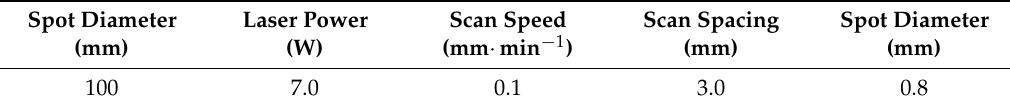
Table 1. Laser sintering